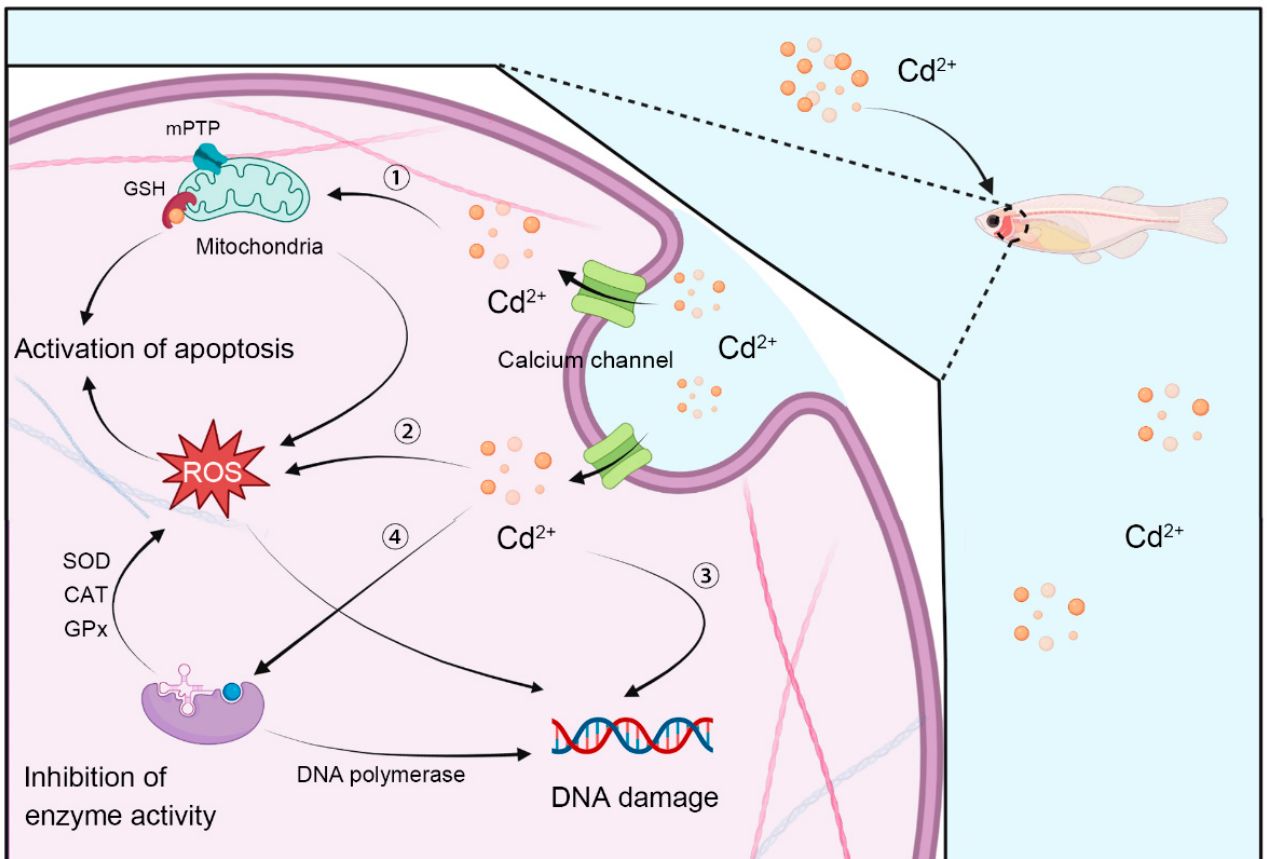
Figure 3. Schematic diagram of Cd toxicity on molecule and cell in fish.